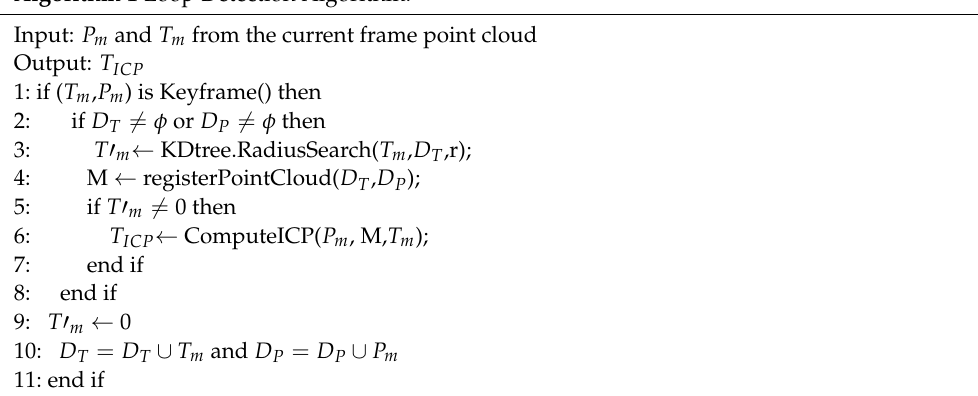
Algorithm 1 Loop Detection